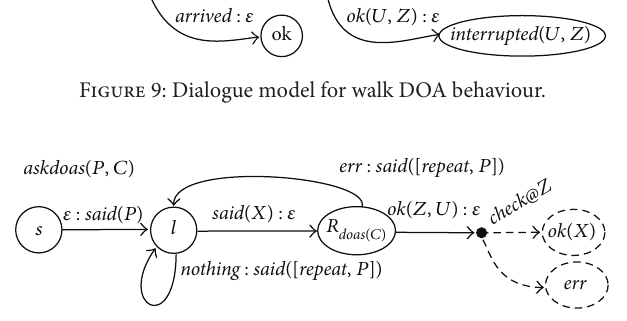
Figure 10: Dialogue model for ask DOA